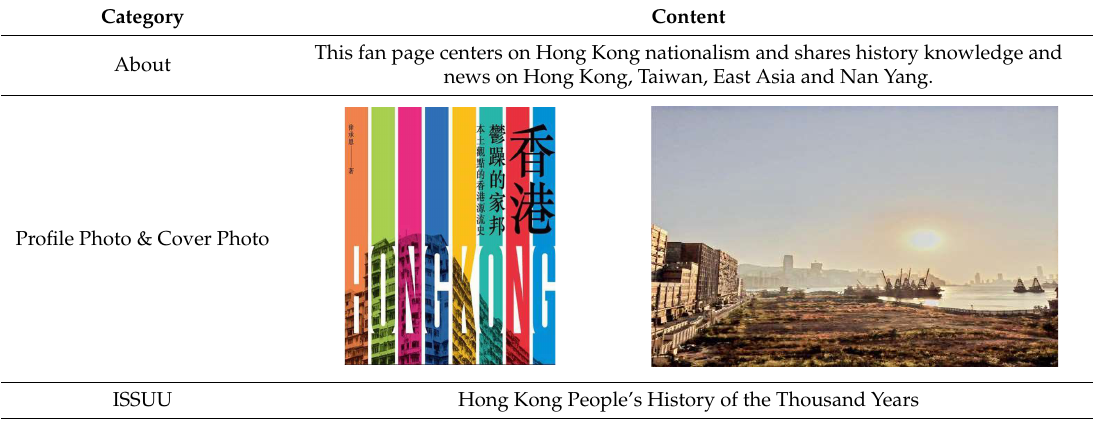
Table 1. The basic information of HNH.